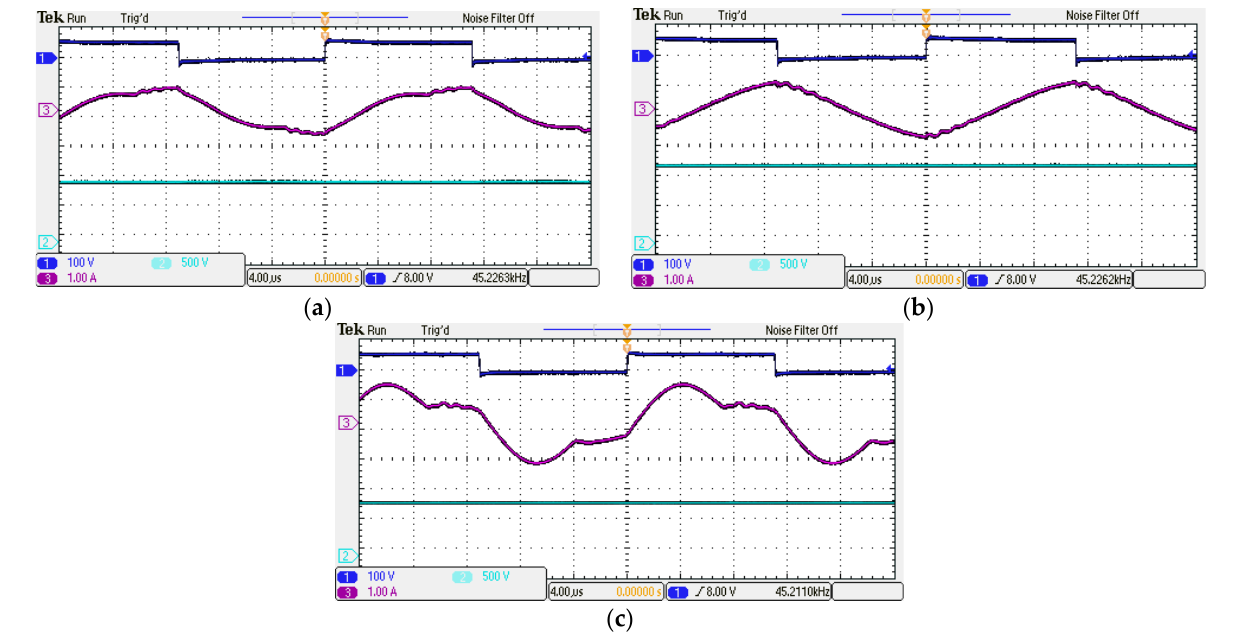
Figure 17. LLC resonant converter improvement for primary-side switches at below resonant fre- quency f SW = 45 kHz: ( a ) light load Q = 0.2; ( b ) open circuit; ( c ) heavy load Q = 0.8.